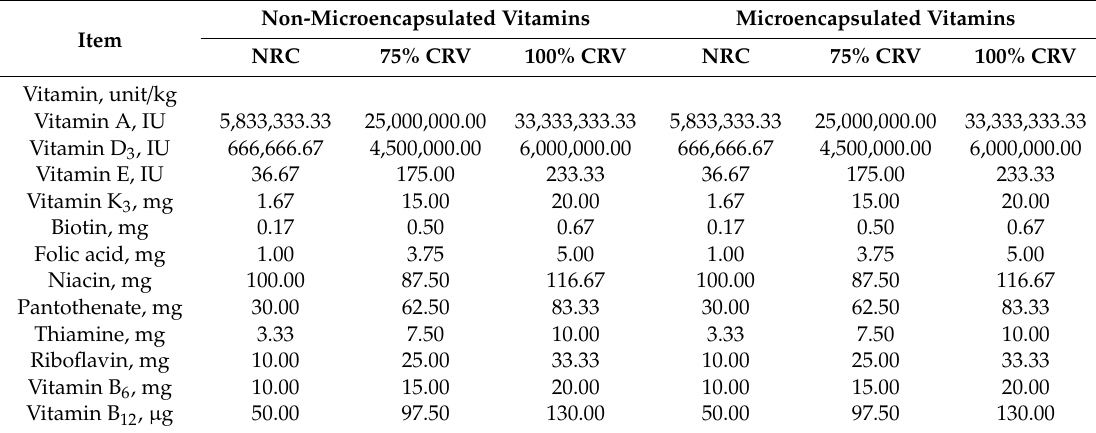
Table 2. The composition of vitamin premixes used in each treatment for experimental 2 1 .